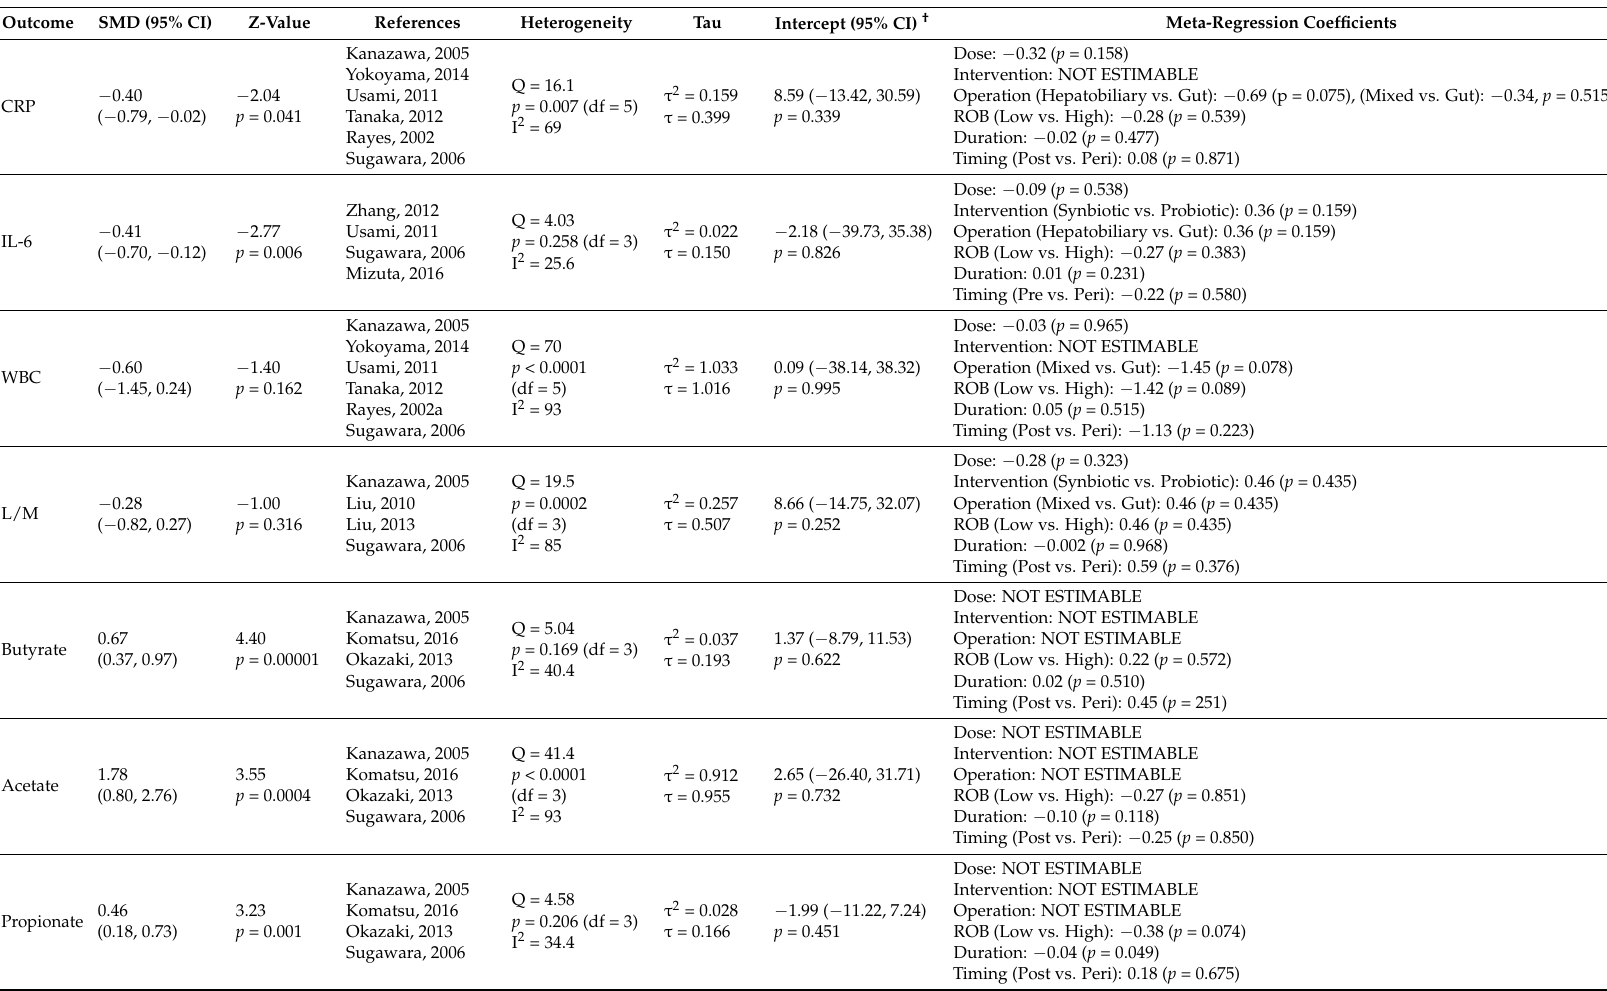
Table 3. Primary outcomes associated with gut barrier implicated in potential mechanisms of probiotic/synbiotic